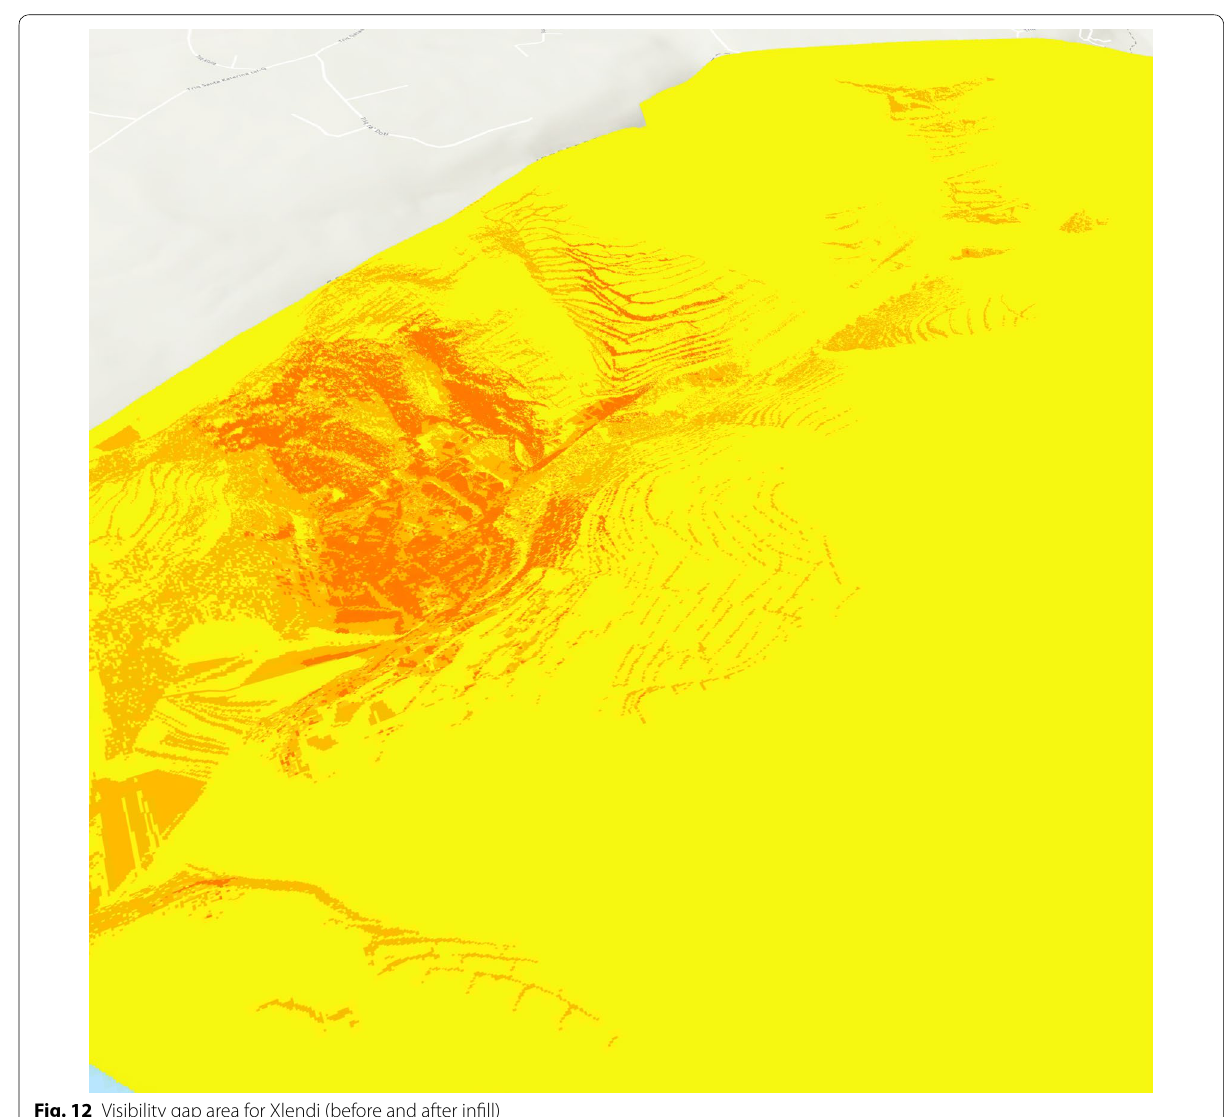
Fig. 12 Visibility gap area for Xlendi (before and after